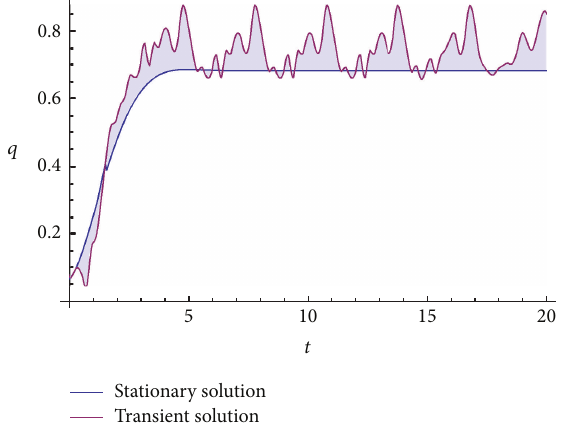
Figure 4: Comparison of the stationary (blue) and transient (red) material throughput at dispatch